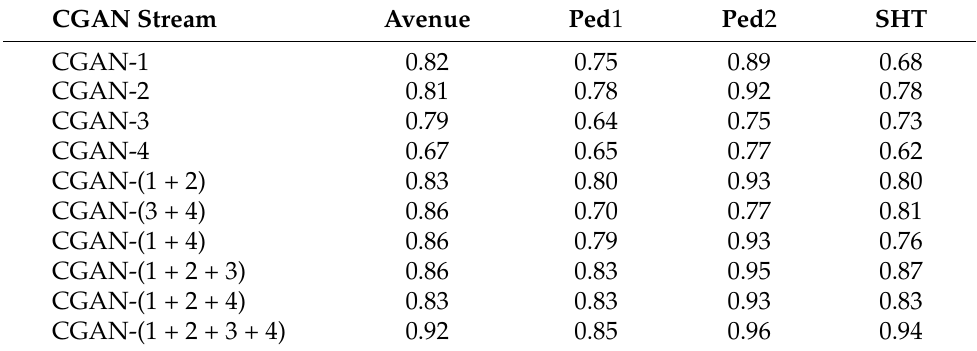
Table 3. Frame-level AUC performance on all 4 benchmarks using PSNR encoding and SVM classifiers. 80% samples of the test set are used for training SVM. SHT = ShanghaiTech.